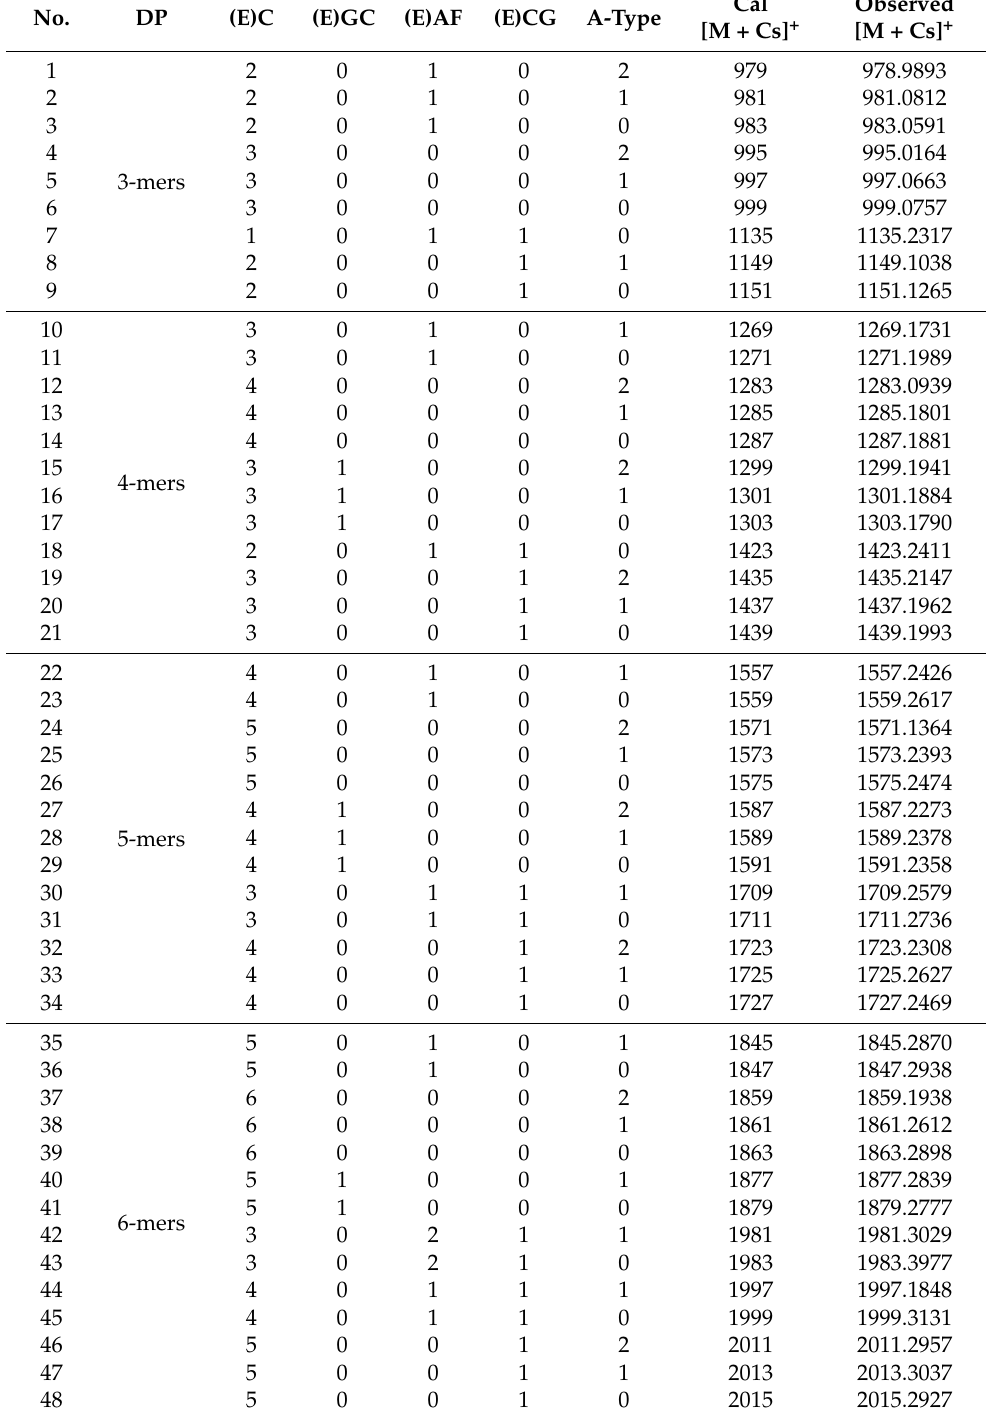
Table 9. MALDI-TOF MS analysis results of the 70% acetone eluent of the rhizome of F. dibotrys